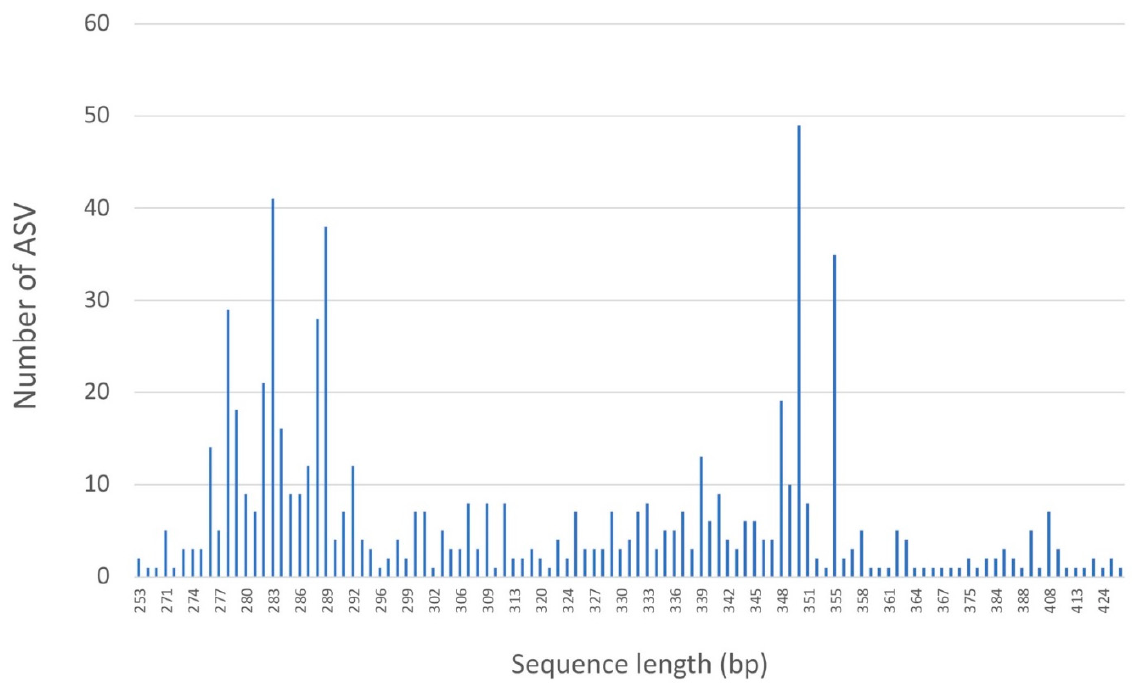
Figure 2. Distribution of ITS2 sequence lengths across all samples.